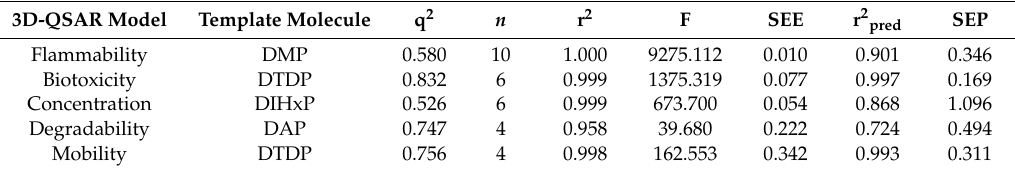
Table 4. 3D-QSAR models’ parameters of PAEs’ flammability, biotoxicity, enrichment, degradability, and mobility single-e ff ect.